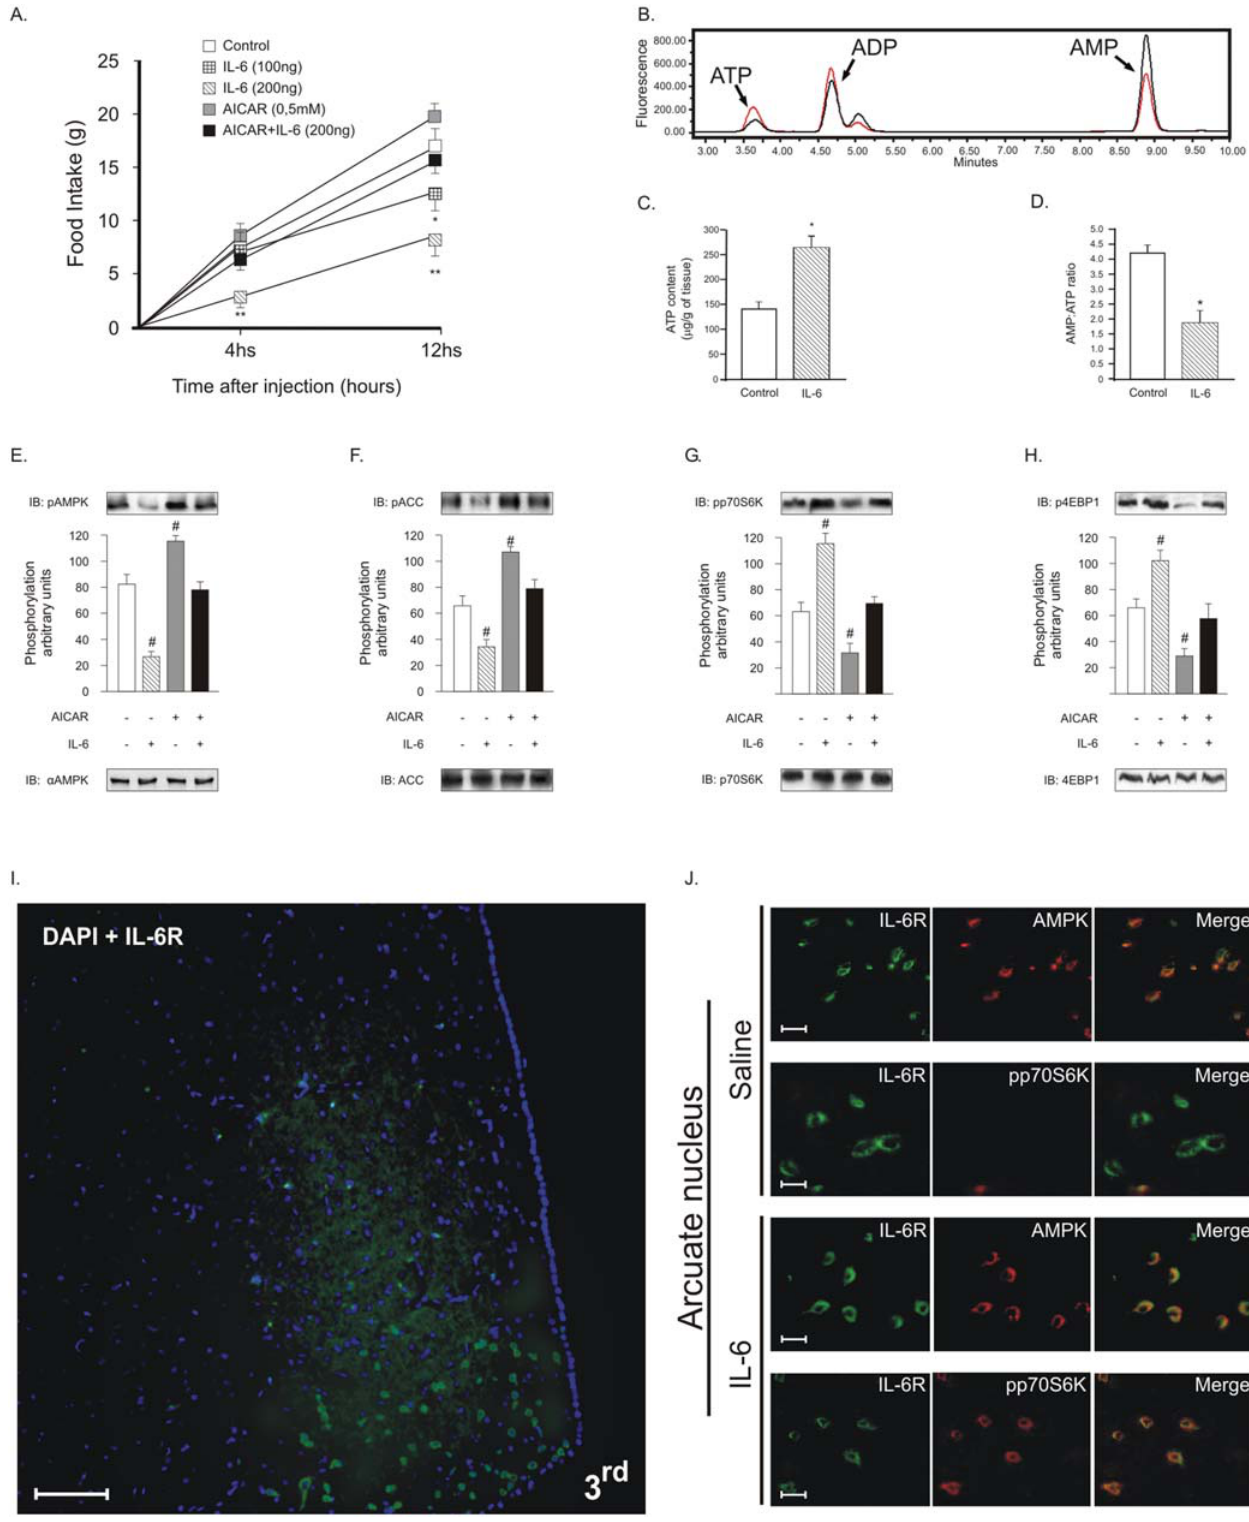
Figure 1. Effects of IL-6 on food intake, hypothalamic AMPK/mTOR activity and ATP content. (a) Effect of i.c.v. administration of IL-6 on food intake; pretreatment with AICAR blocks IL-6-induced anorexia ( n =12–15 animals per group). (b, c, d) Typical chromatographic run (b) depicting the ATP, ADP, and AMP fractions in control (black line) and in i.c.v. IL-6 treated animals (red line), as mean ATP content and as AMP:ATP ratio (c, d). (e, f, g, h) Representative Western blots of four independent experiments showing hypothalamic lysates from Wistar rats. Phospho-AMPK thr172 , threonine-phosphorylated AMPK and total AMPK (e); phospho-ACC ser79 , serine phosphorylated ACC and total ACC (f); phospho-p70S6Kinase thr389 , threonine phosphorylated p70S6Kinase and total p70S6K (g); phospho-4EBP1 thr70 , threonine phosphorylated 4EBP1 and total 4EBP1 (h). Confocal